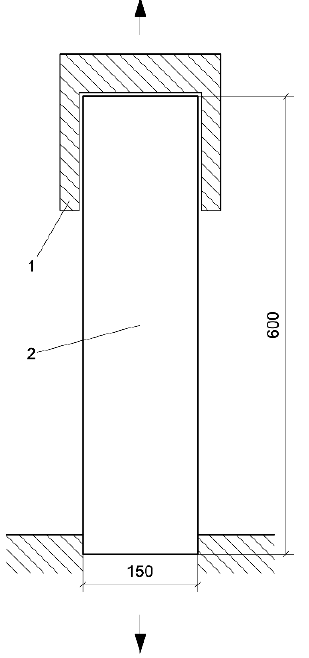
Figure 4. Scheme of testing a sample for determining the axial tensile strength: (1) active capture, (2) sample.